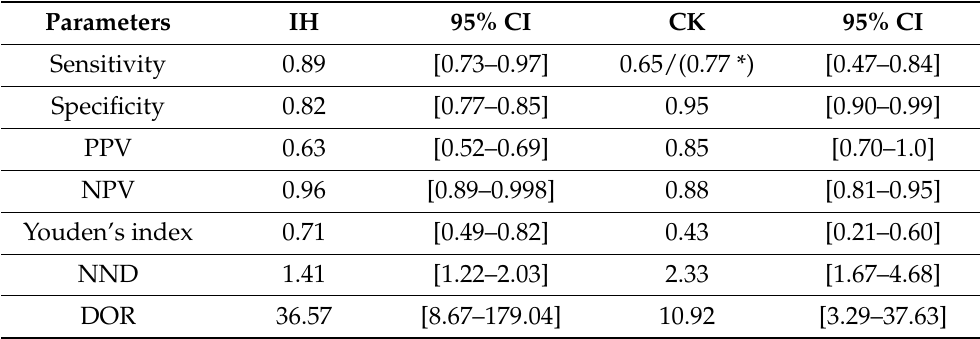
Table 3. Overall diagnostic indices of the IH and CK-PCR assays compared to conventional methods as the diagnostic gold